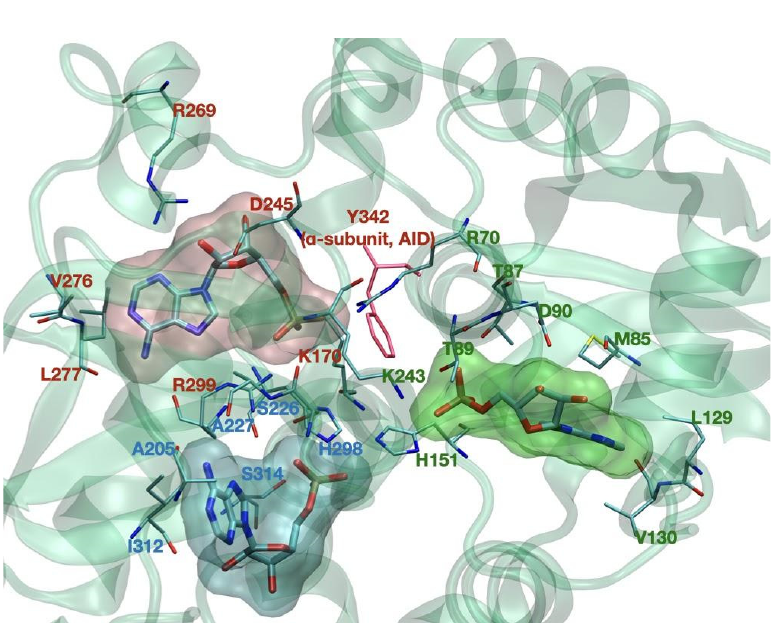
Figure 2. CBS binding sites of the γ subunit. Key binding residues are noted in green for CBS1, in red for CBS3, and in blue for CBS4. Tyr-342, pictured in red, belongs to the AID domain of the α subunit.